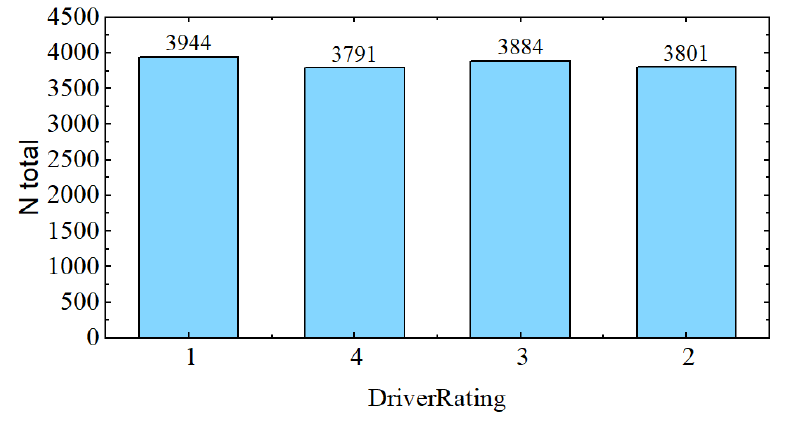
Figure 5. Driver rating class distribution as per the total observations. N total represents the count of accidents claims for each class, fraudulent or not.